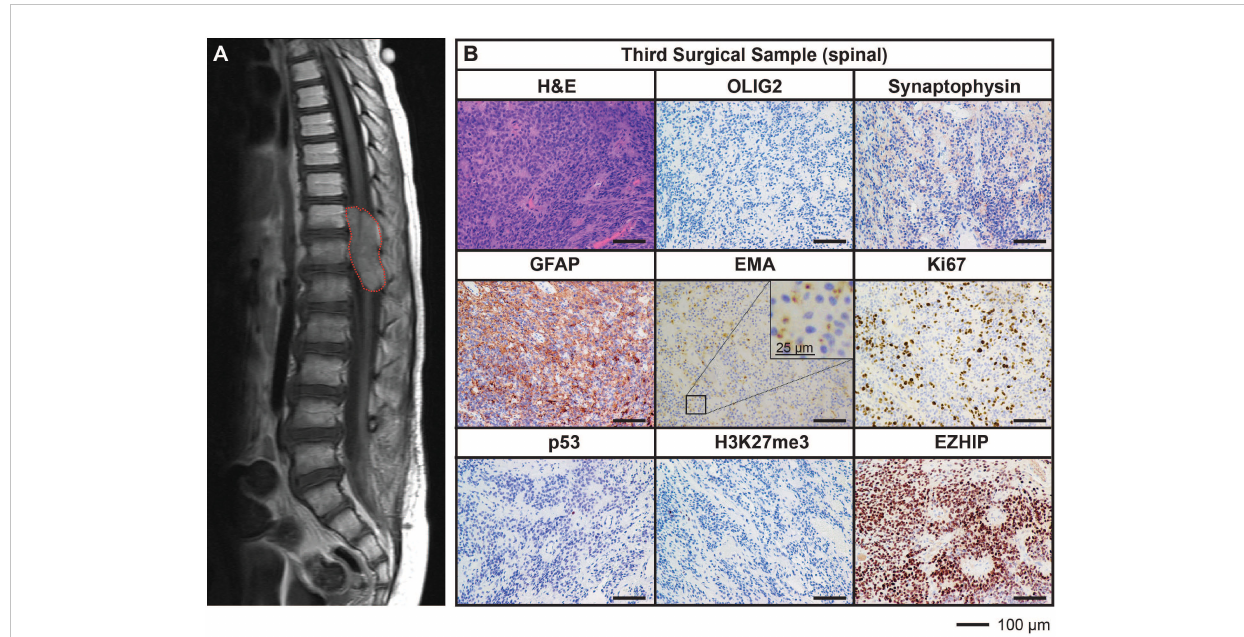
FIGURE 3 MRI and histological assessments of the third surgical sample (spinal) were consistent with the lesion being an additional metastatic tumor arising in the spine from the initial PFA EPN. (A) MRI depicting a large spinal metastasis ( red dotted line ). (B) Tumor tissue was stained with H&E or using IHC with the antibodies indicated ( brown ) followed by hematoxylin counterstain ( blue ). Histological fi ndings were consistent with the features of the primary tumor. Ki67 proliferative index was estimated to be 25%. Scale bars are as